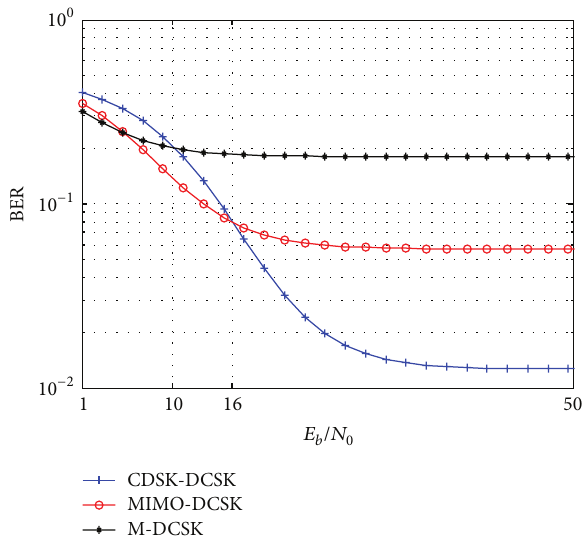
Figure7:SimulatedBERsversus 𝐸 𝑏 /𝑁 0 formultiuserCDSK-DCSK, MIMO-DCSK, and M-DCSK with 𝑀 = 5 and 𝑈 =